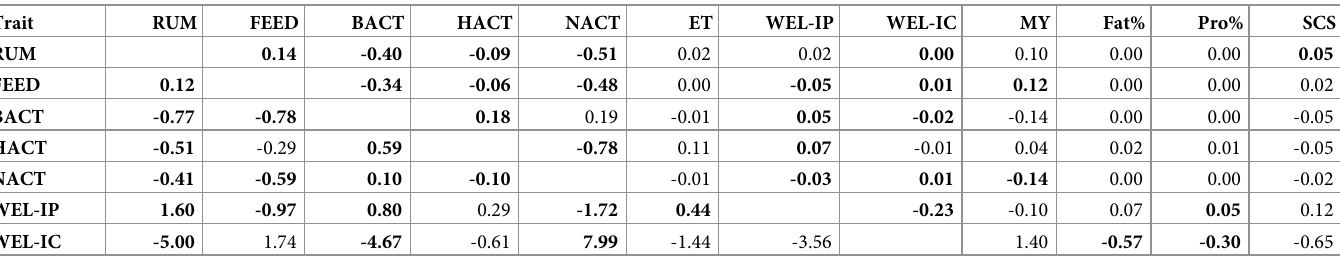
Table 3. Regression coefficients among sensor behavior traits and between sensor behavior traits and production traits. Trait RUM